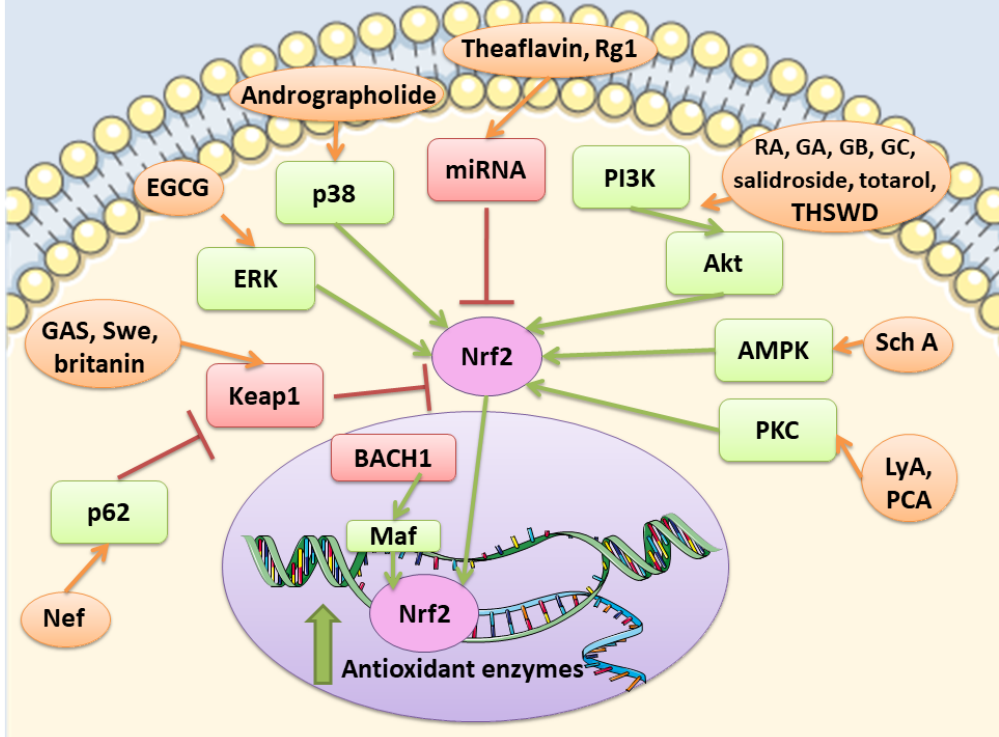
Figure 14. Schematic representation of the different pathways activated by the natural compounds that are involved in Nrf2 modulation. The orange ovals indicate the compounds that activated each